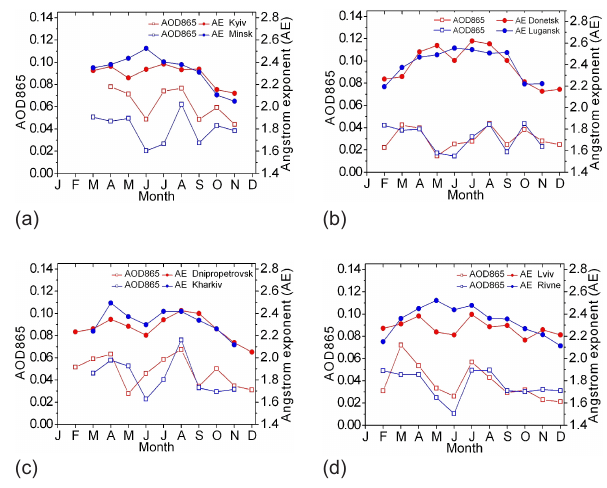
Figure 4. Seasonal variations of AOD (865nm) values and AE (670–865nm) values averaged over 2008–2011 in the atmosphere over the Kyiv, Minsk, Donetsk, Lugansk, Dnipropetrovsk, Kharkiv, Lviv, and Rivne urban–industrial areas based on POLDER